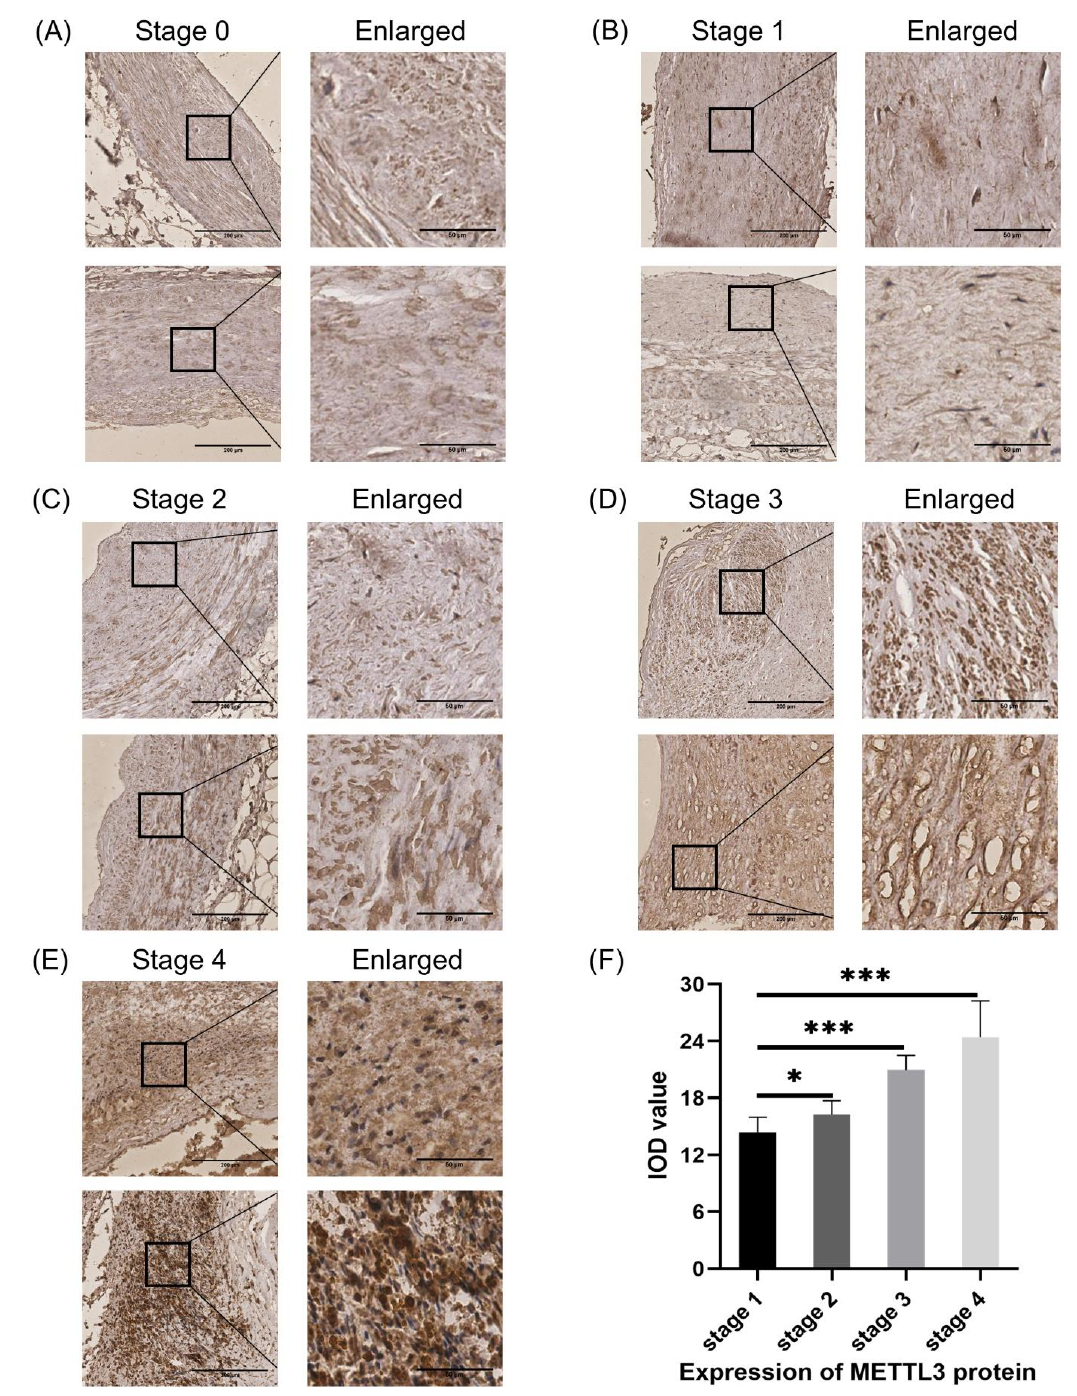
Figure 8. The expression of METTL3 at different stages of atherosclerosis, analyzed by immuno- histochemical assay: ( A ) The expression level of METTL3 at Stage 0 of atherosclerosis. ( B ) The ex- pression level of METTL3 at Stage 1 of atherosclerosis. ( C ) The expression level of METTL3 at Stage 2 of atherosclerosis. ( D ) The expression level of METTL3 at Stage 3 of atherosclerosis. ( E ) The ex- pression level of METTL3 at Stage 4 of atherosclerosis. ( F ) The bar chart and differences between the other groups and Stage 1. Stage 0, normal tunica intima; Stage 1, fatty streak tunica intima; Stage 2, fibrous plaques tunica intima; Stage 3, atherosclerotic tunica intima; Stage 4, secondary affection tunica intima. Low magnification (40 ); scale bar: 200 μm. High magnification (200 ); scale bar: 50 μm. * p < 0.05. *** p < 0.001.